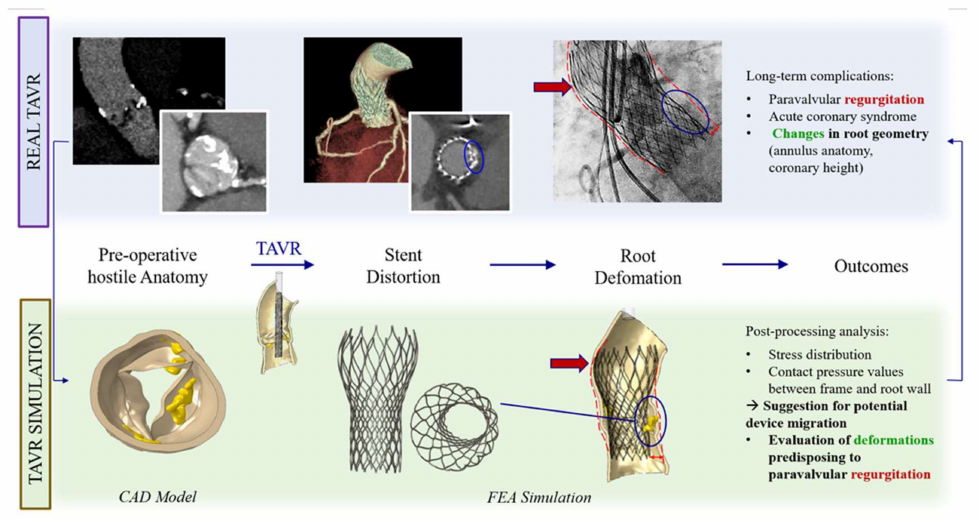
Figure 1. FEA may predict possible TAVR